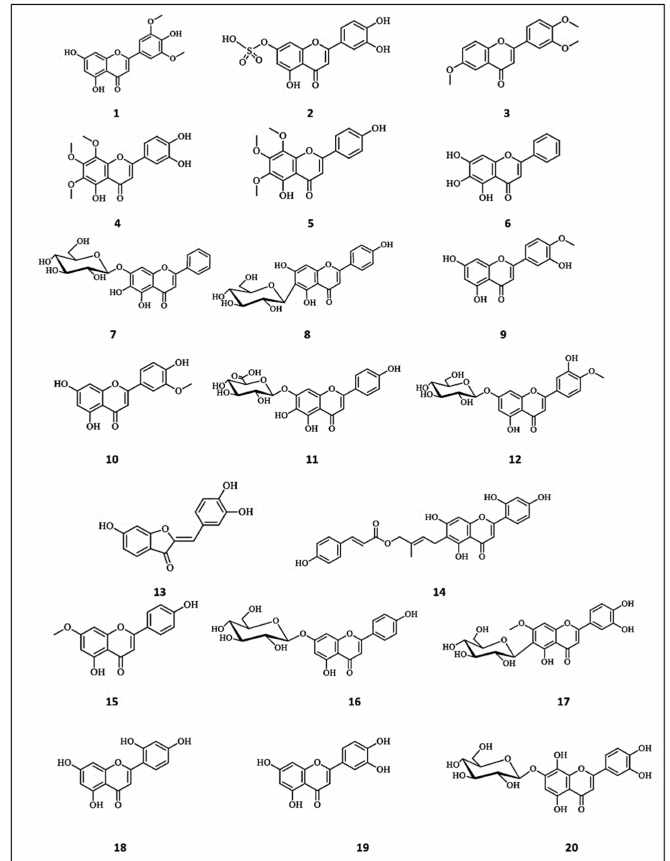
Figure 2. The chemical structures of flavones with anti-tyrosinase activity. ( 1 ) Tricin; ( 2 ) Luteolin-7-sulfate; ( 3 ) 2 (cid:48) ,4 (cid:48) ,6-trimethoxyflavone; ( 4 ) 3 (cid:48) ,4 (cid:48) ,5-trihydroxy-6,7,8-trimethoxyflavone; ( 5 ) 4 (cid:48) ,5-dihydroxy-6,7,8-trimethoxyflavone; ( 6 ) Baicalein; ( 7 ) Oroxin A; ( 8 ) Isovitexin; ( 9 ) Diosmetin; ( 10 ) Chrysoeriol; ( 11 ) Scutellarin; ( 12 ) 3 (cid:48) ,5-dihydroxy-7-( β - D - glucopyranosyloxy) − 4 (cid:48) -methoxyflavone; ( 13 ) Sulfuretin; ( 14 ) Artocaepin E; ( 15 ) Genkwanin; ( 16 ) Apigenin-7- O - β - D - glucopyranoside; ( 17 ) Swertiajaponin; ( 18 ) Norartocarpetin; ( 19 ) Luteolin; ( 20 ) Hypolaetin-7- O - β - D